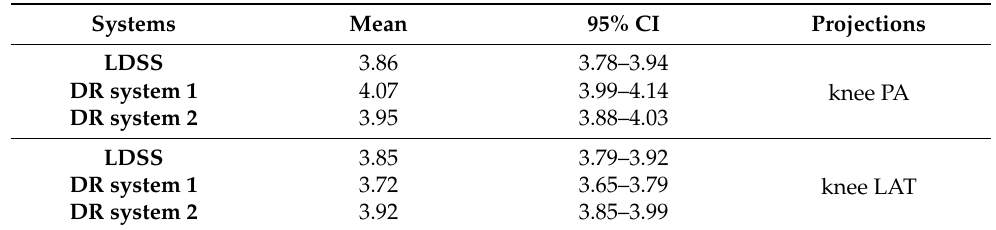
Table 12. Means of mean VGA values, upper and lower bound of 95% CI for all imaging systems in the knee PA/LAT protocol. Systems